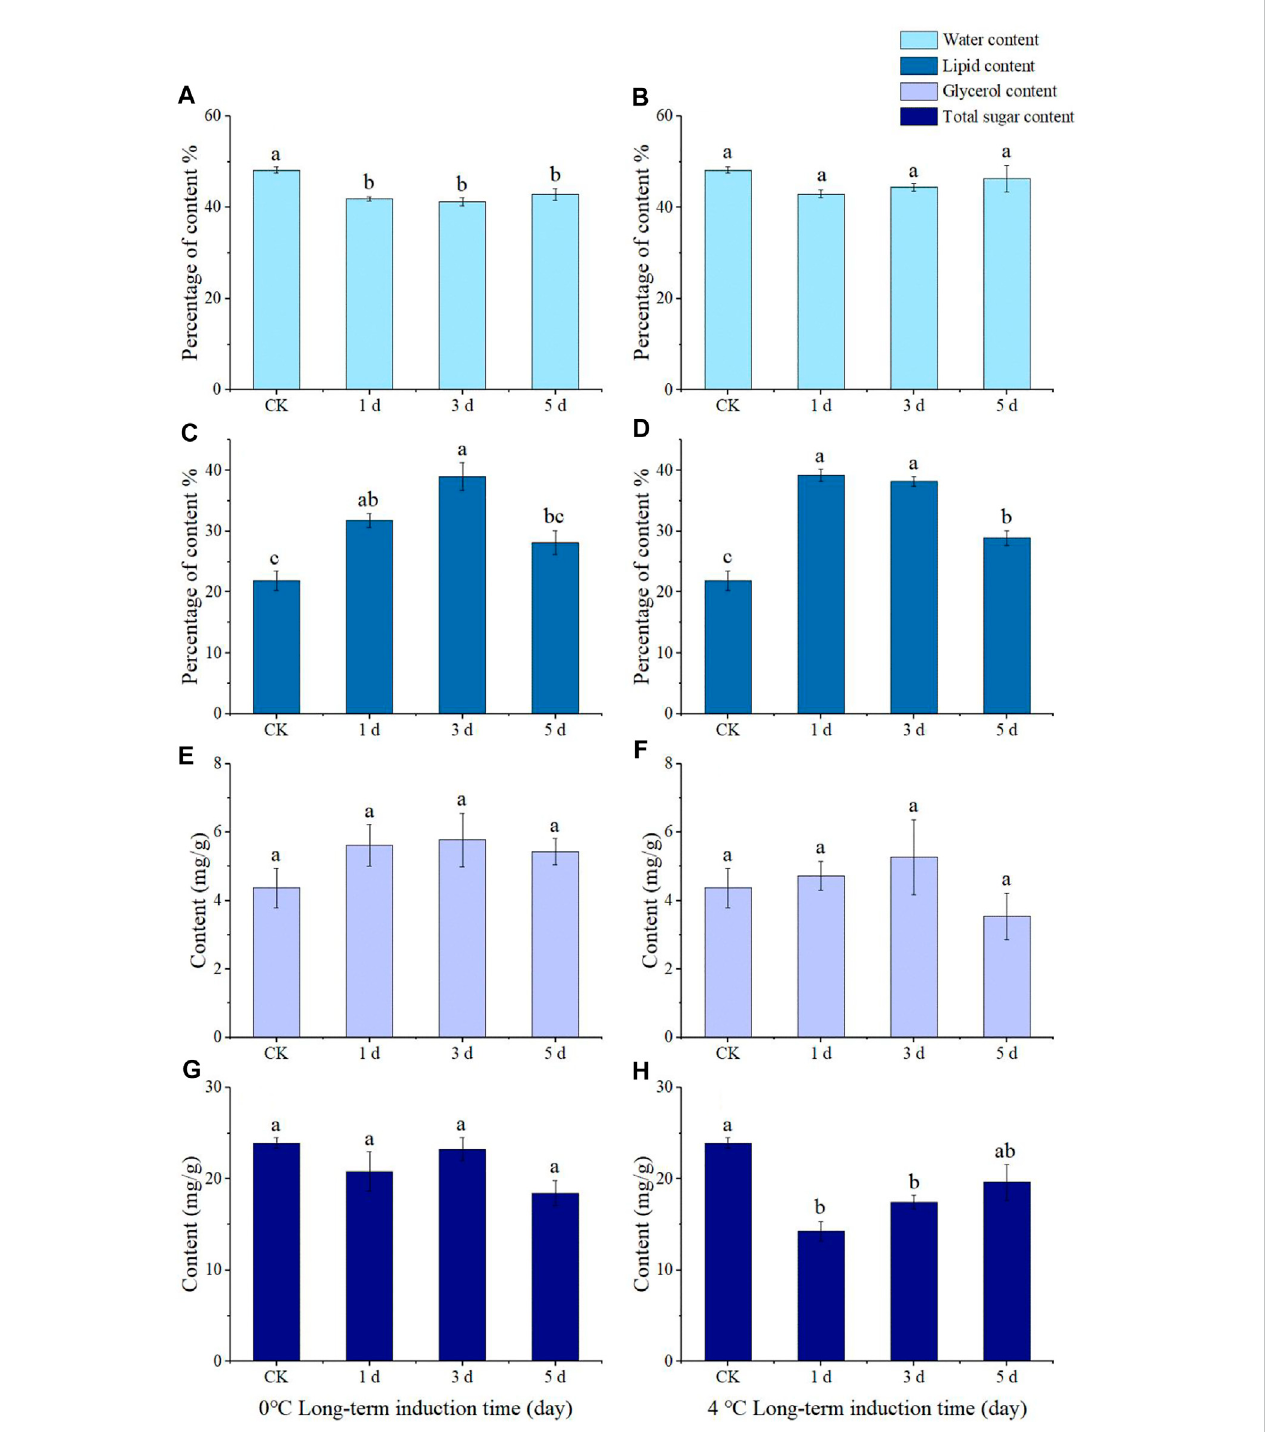
FIGURE 5 Watercontent (A,B) ,lipidcontent (C,D) ,glycerolcontent (E,F) ,andtotalsugarcontent (G,H) of Megabruchidiusdorsalis adultsinducedbylong-termlow temperature (0 ° C: A, C, E,G; 4 ° C: (B,D,F,H) for 1, 3, and 5 d.The data were Mean ± SE, and the different lowercase letters indicated a signi fi cant difference among time treatments under the same physiological indexes (Kruskal – Wallis test, One-Way ANOVA, Tukey, p <